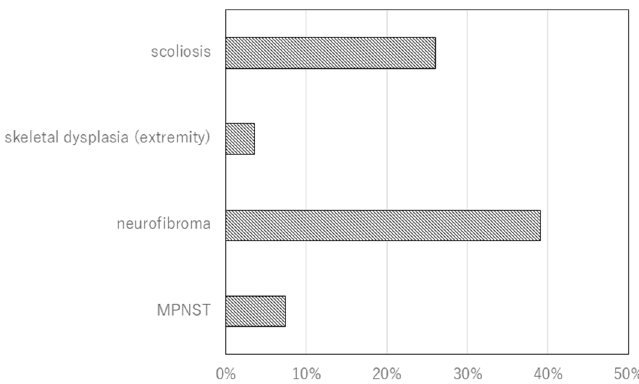
Figure 5. Diseases treated by orthopedic surgeons. Ratio to the total number of patients. Neurofibroma: deep- seated neurofibroma counted. Cutaneous neurofibroma not